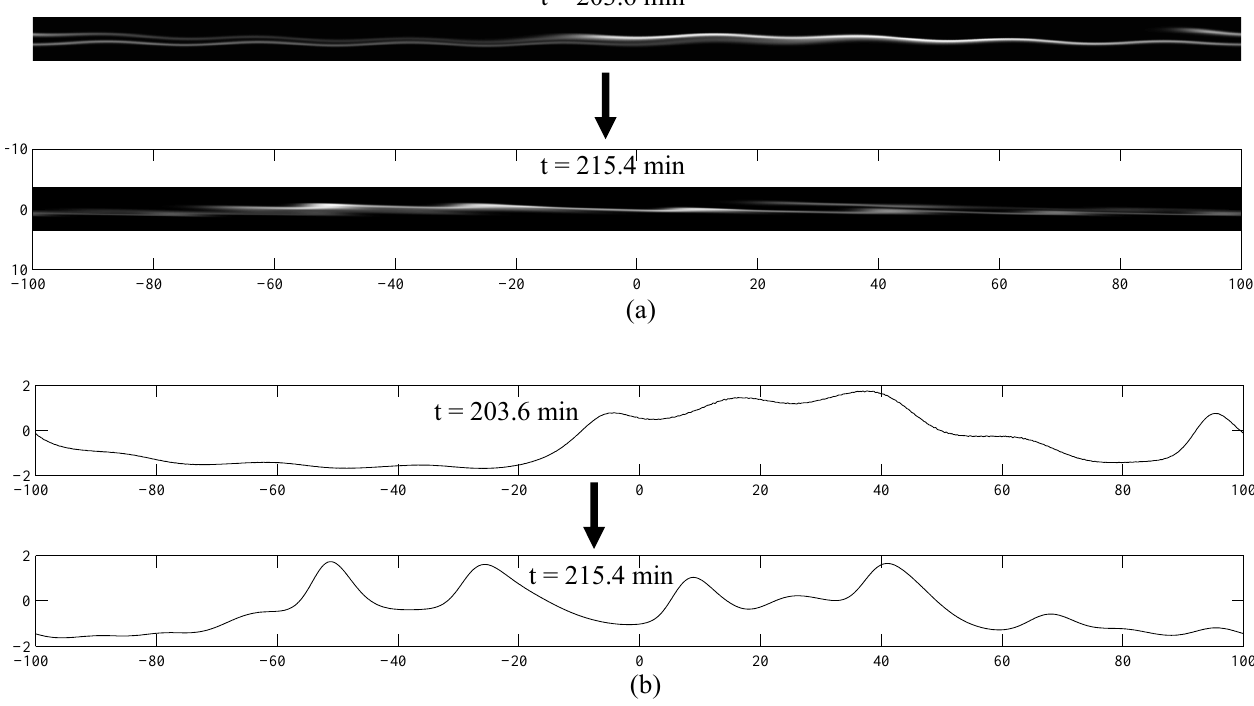
Fig. 7. The effects of a secondary, 25km wavelength seeding of the E s layer (e.g. by a gravity wave), after the 200km seeding (by the F layer) Figure 7: The effects of a secondary, 25 km wavelength seeding of the E s layer (e.g. by a gravity wave), after the 200 km has run its course. The times shown are measured from the initial 200km seeding, except note that a ± 0.25km amplitude, 25km wavelength seeding (by the F layer) has run its’ course. The times shown are measured from the initial 200 km seeding, except note modulation has been imposed on the figures labeled t = 203 . 6min. Plasma density images are shown in panel (a) , and the corresponding that a ± 0 . 25 km amplitude, 25 km wavelength modulation has been imposed on the figures labeled t = 203 . 6 minutes. electric fields are shown in panel (b) . The axes for all figures are described in Sect. 2.2, and summarized in Fig. Plasma density images are shown in panel (a), and the corresponding electric fields are shown in panel (b). The axes for